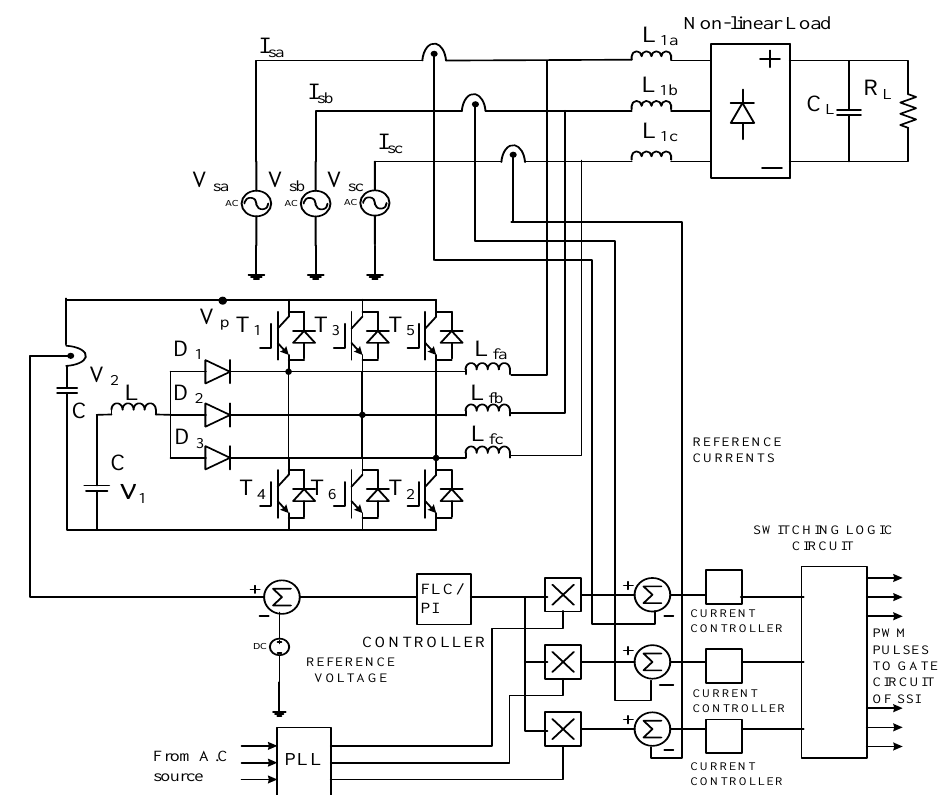
Figure 3. Circuit diagram of Three-phase SSI-based SAPF connected to the supply and non-linear load.